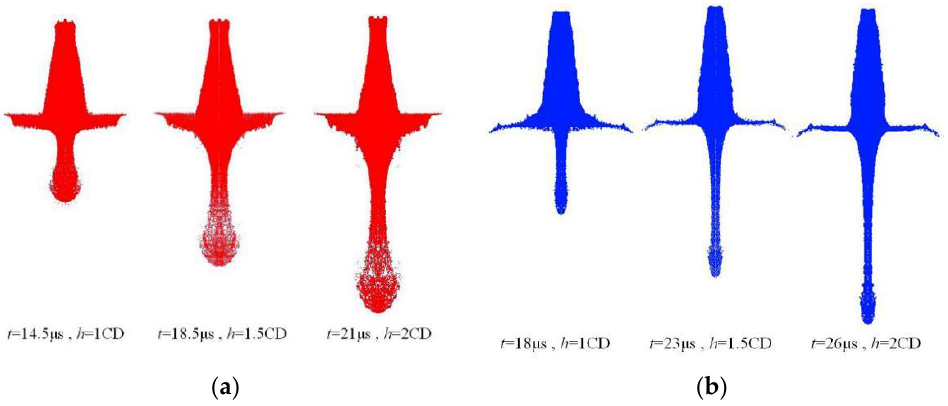
Figure 2. Comparison of jet formation characteristics: ( a ) reactive composite jet and ( b ) Cu jet.